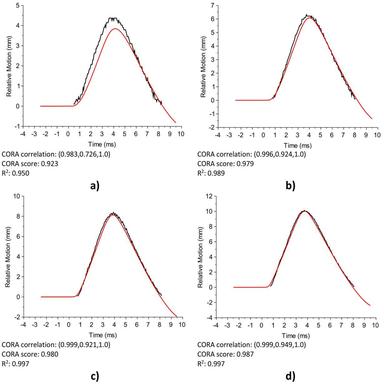
Comparison of experimental and simulated gel bulge (incorporating initial stiffening effect) time courses for impact velocities of a) 1.13 m/s, b) 1.50 m/s, c) 1.87 m/s, and d) 2.40 m/s for Sylgard 3–6636 (1:2). CORA scores, as well as R2 values, are provided. Material parameters used for the simulated data were derived from the 2.40 m/s impact velocity experiment. The maximum body forces needed to account for initial stiffening were determined to be a) 15.9 N, b) 19.4 N, c) 26.2 N, and d) 31.2 N.